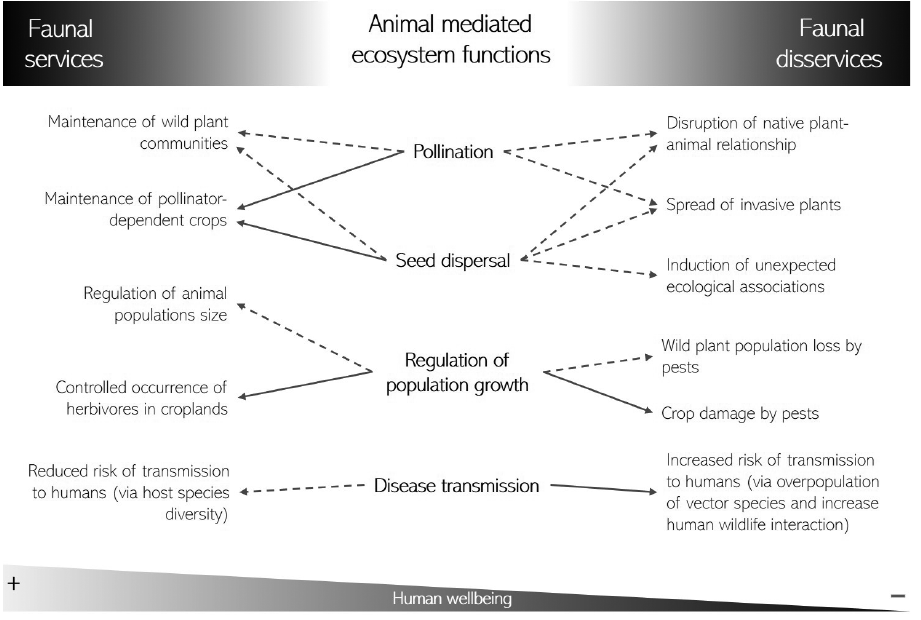
Figure 1. Animal populations as source of services and disservices. The same ecosystem function medi- ated by animal populations may enhance (faunal service) or undermine (faunal disservice) human well- being and it can manifest directly (solid arrows) or indirectly (dashed